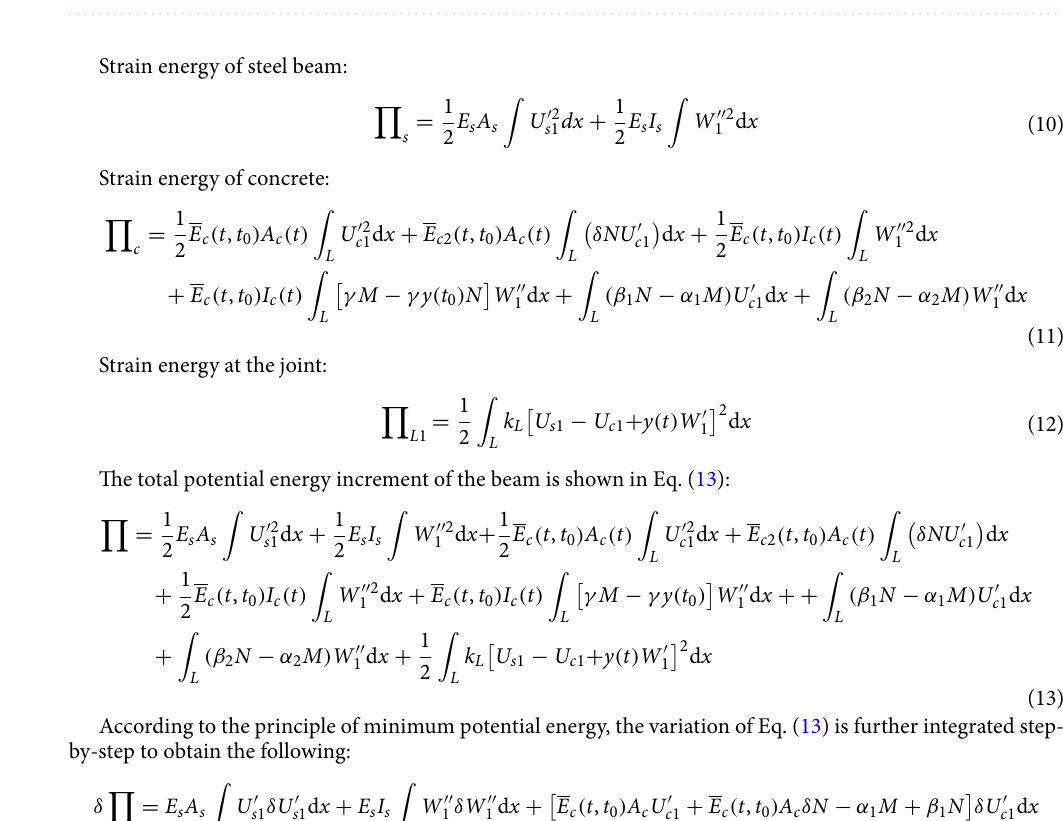
Figure 2. Influence of loading under creep on interface slip increment concentrated